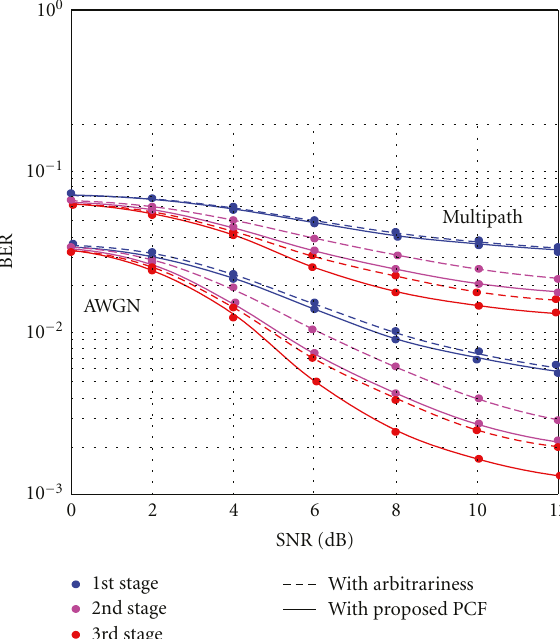
Figure 7: The BER performance at each stage for three-stage GR based on the PPIC with hard decisions for di ff erent PCFs at the first stage, that is, the average value and an arbitrary value: AWGN and multipath channels.